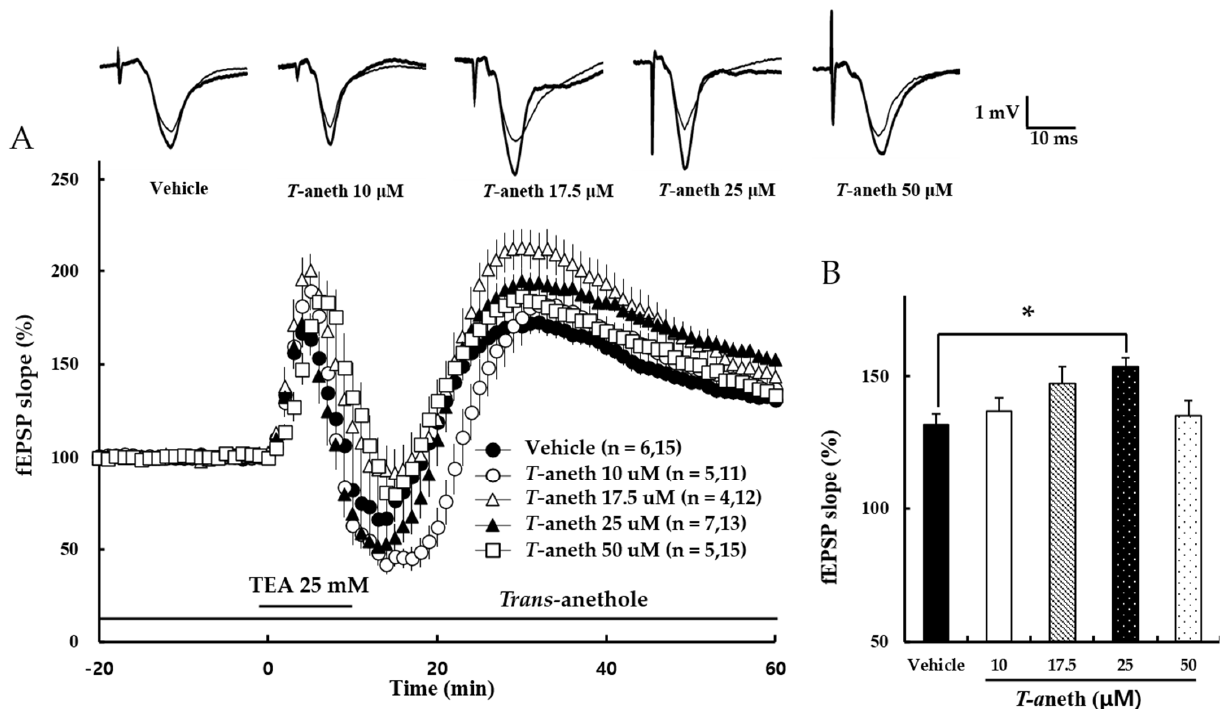
Figure 3. Trans ‐ anethole (25 μ M) enhances NMDA receptor ‐ independent LTP. ( A ) NMDA receptor ‐ independent LTP was induced by TEA (25 mM), which was applied during the time period indicated by the bar and then washed out. The numbers of mice and slices, respectively, are shown in parentheses. Filled circles, open circles, open triangles, filled triangles, and open squares indicate the Vehicle group, 10 μ M Trans ‐ anethole group, 17.5 μ M Trans ‐ anethole group, 25 μ M Trans ‐ ane ‐ thole group, and 50 μ M Trans ‐ anethole group, respectively. ( B ) Values represent percent changes in the fEPSP slope observed at 58–60 min after TEA exposure. Statistical significance (* p < 0.05 vs. Vehicle) was calculated by one ‐ way ANOVA followed by Tukey HSD test. Typical traces of fEPSPs recorded 1 min before (thin traces) or 60 min after (thick traces) TBS are shown above. T ‐ aneth, Trans ‐ anethole; fEPSP, field excitatory synaptic potential.